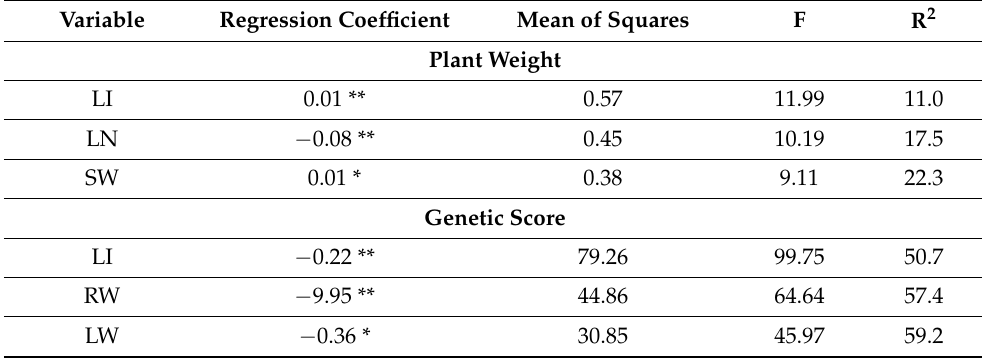
Table 6. Forward regression in drought conditions for when plant weight and genetic score were considered as dependent variables and the other attributes as independent variables.